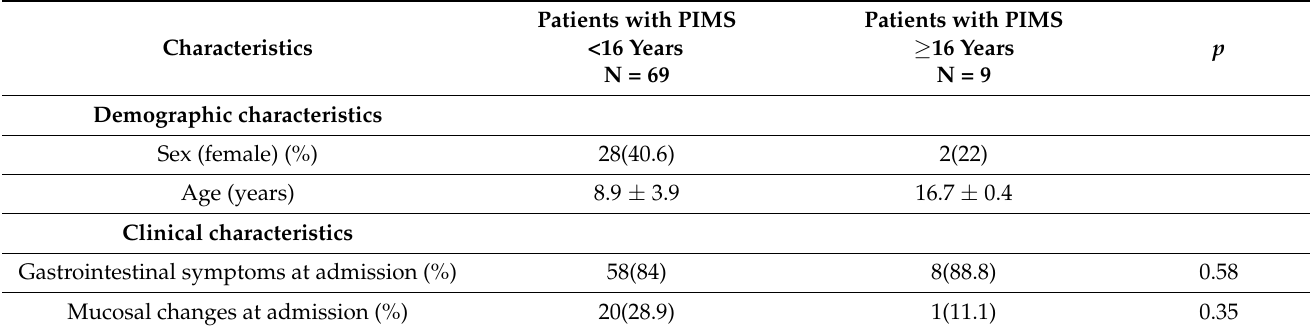
Table 3. Clinical and laboratory data of 69 patients with pediatric multisystem inflammatory syn- drome (PIMS) <16 years and nine patients ≥ 16